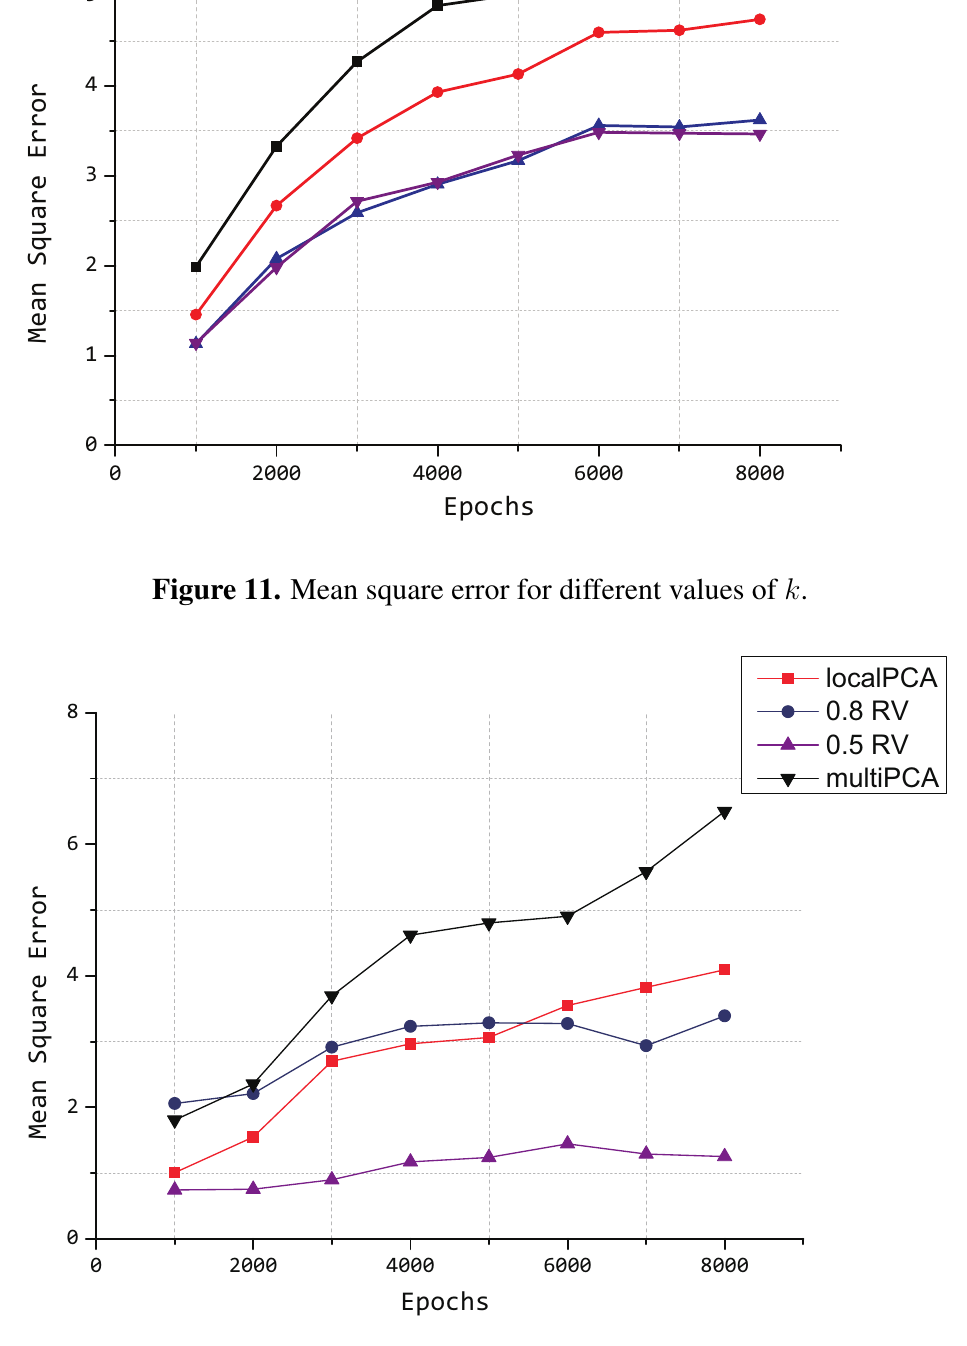
Figure 12. Mean square error by different